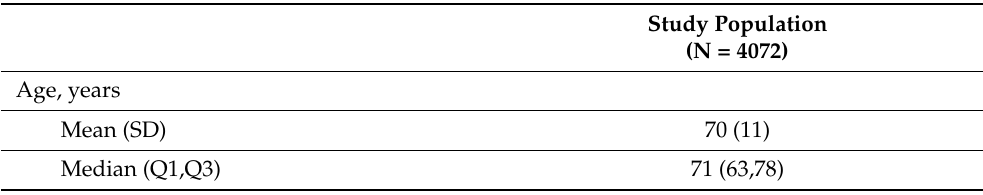
Table 1. Sociodemographic of the study population at